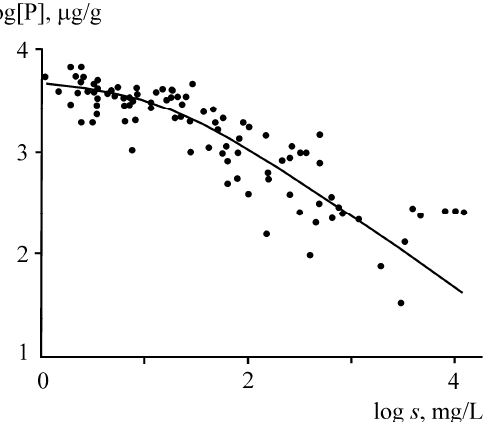
Figure 5. Relationship between the phosphorus content in suspended matter and the turbidity ( s ) of river waters [43].